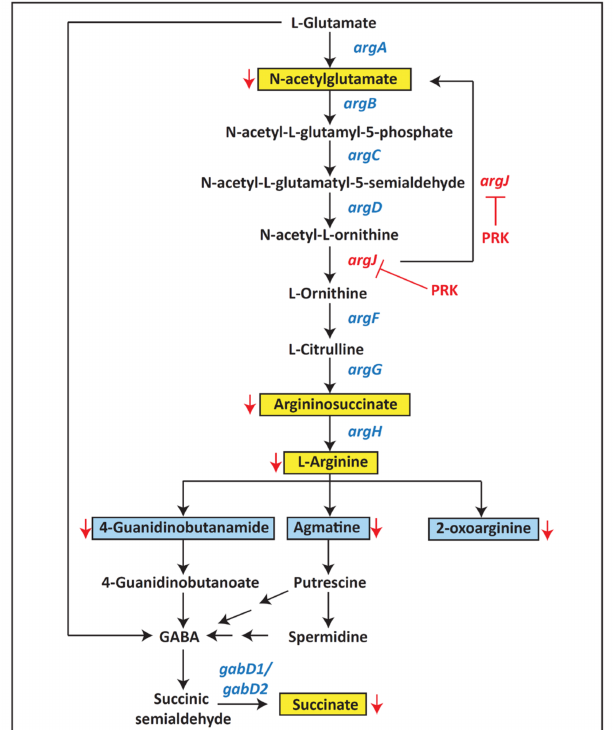
Figure 7. Pathway map of arginine metabolism and GABA shunt. MRM-validated metabolites are highlighted in yellow, while the metabolites dysregulated in the global analysis are highlighted in blue in the